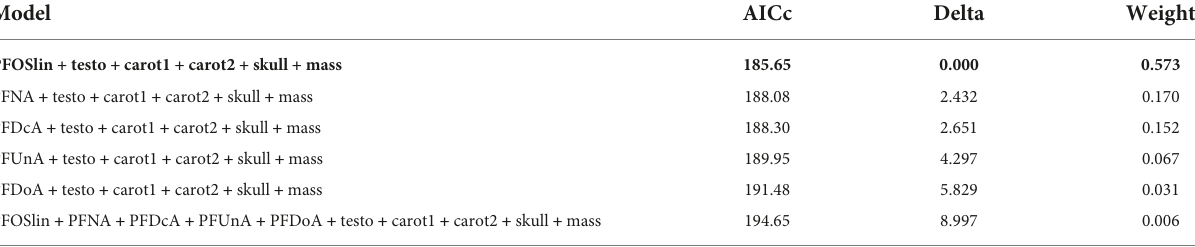
TABLE 2 Rank of lme models for colorimetric variable colour2 as estimated according to Akaike information criterion. Model AICc Delta